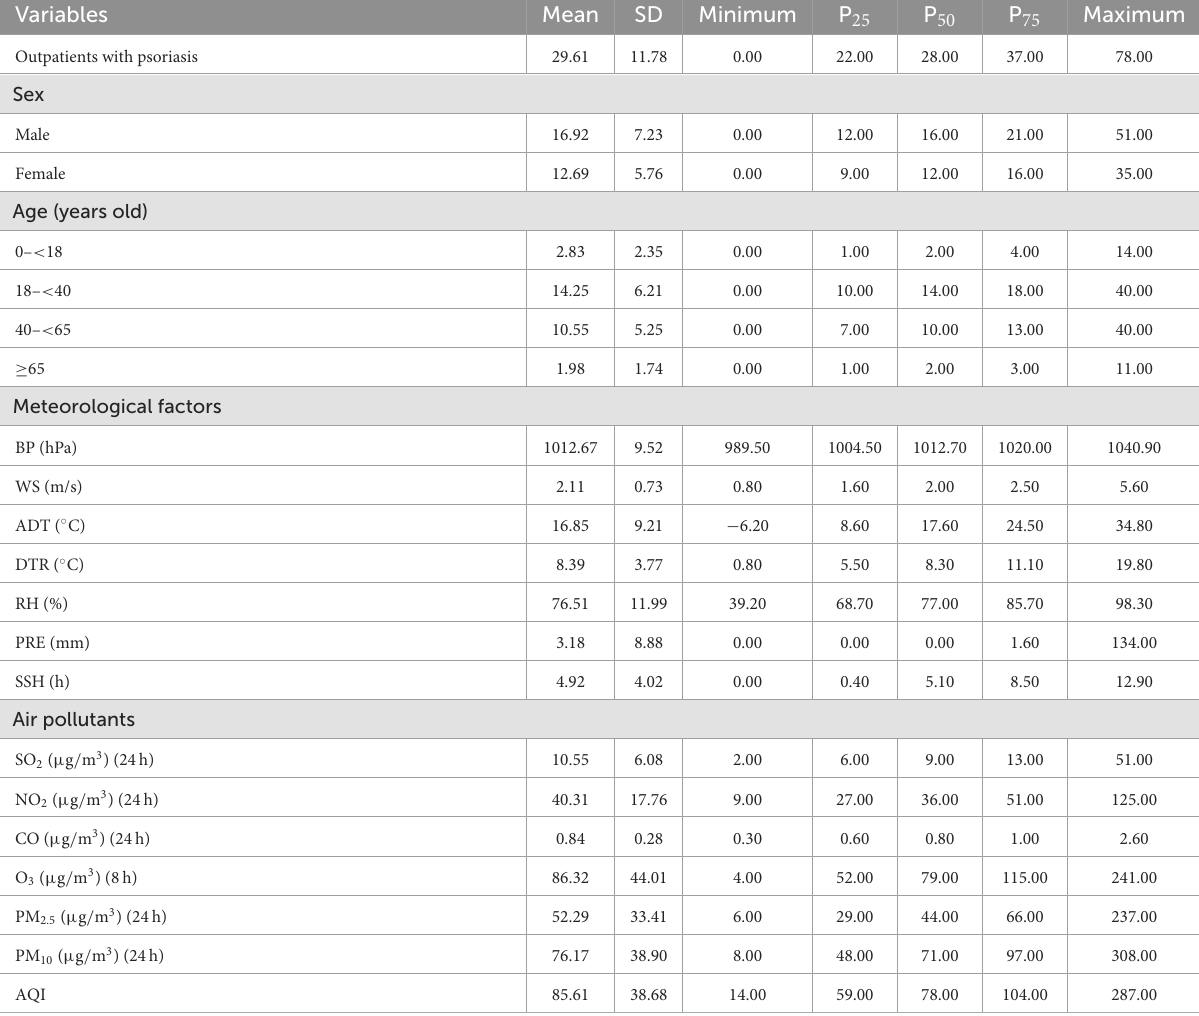
TABLE 1 Characteristics of outpatients with psoriasis, meteorological factors, and air pollutants in Hefei city from 2015 to 2019. Variables Mean Outpatients with